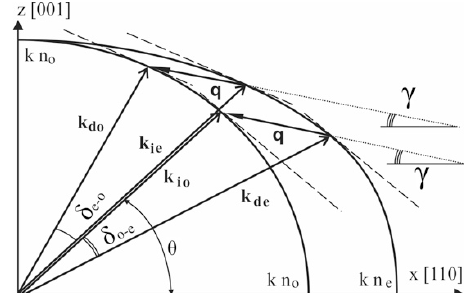
Figure 1. Wave vector diagram of bi-polarization anisotropic acousto-optical (AO) diffraction. k io , k ie , k do , k de —wave vectors of incident ( i ) and diffracted ( d ) light waves of ordinary ( o ) and extraordinary ( e ) polarization; q —wave vector of acoustic wave; θ —angle of incidence; γ —angle of acoustic wave propagation, δ o-e , δ e-o —deflection angles for o → e and e → o modes of diffraction, respectively.